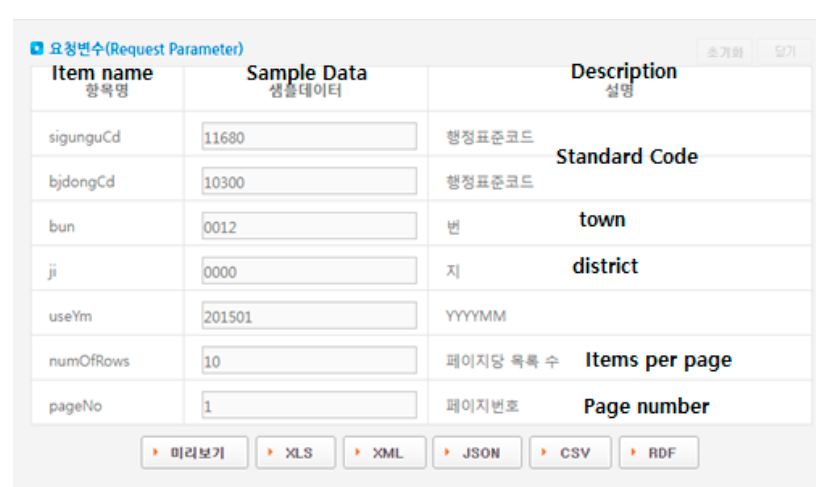
Figure 4. Building energy usage request variable input webpage.